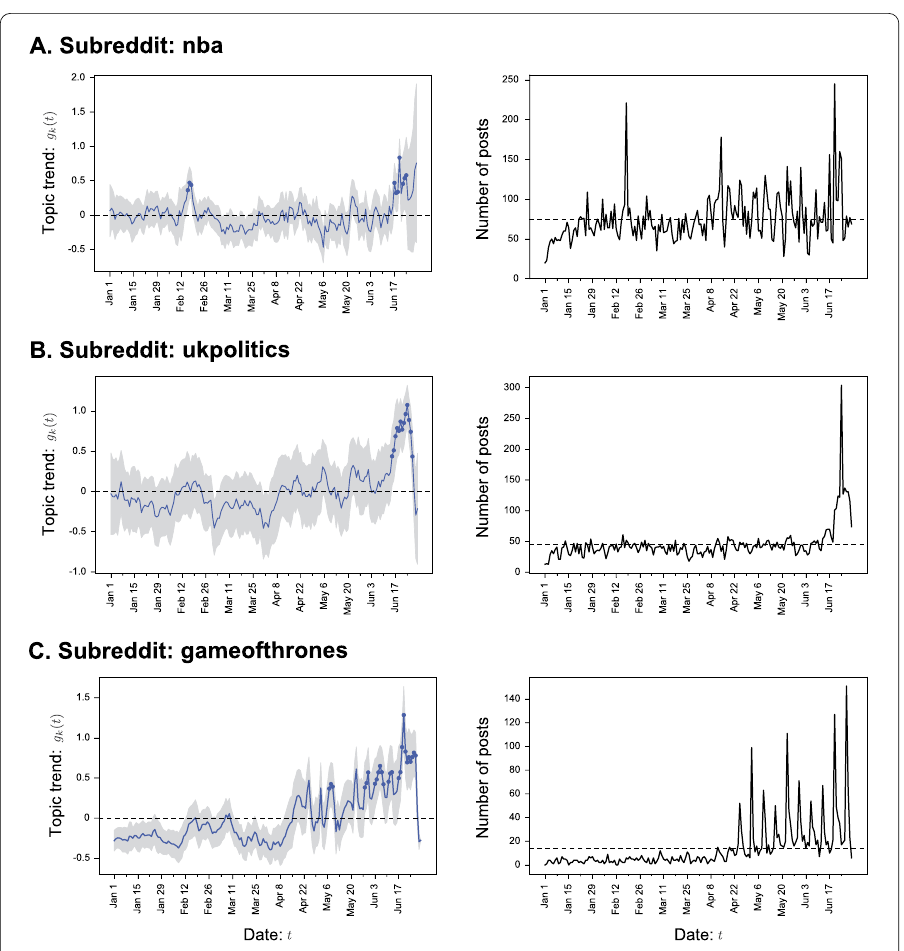
Figure 5 A comparison between the topic trend g k ( t ) (blue in the left panels) and the popularity of posts (black in the right panels) over time in Reddit. The gray area represents the 95% confidence interval of the topic trend. Filled circles mark the days when the topic trend is significantly higher than zero for at least three consecutive days. The three examples are the same as those in Fig.